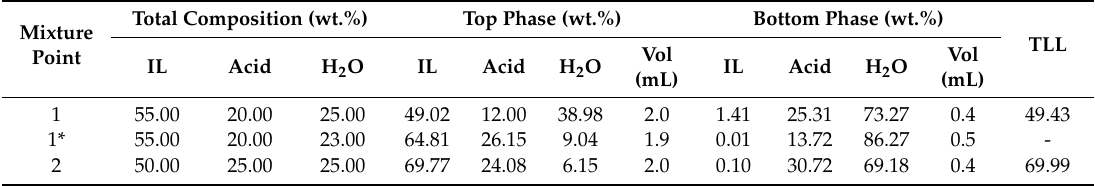
Table 1. Quantification of phase composition for the aqueous biphasic system composed of [P 44414 ]Cl and CH 3 COOH at 313 K (TLL—Tie Line Length). The mixture point 1* has the same initial [P 44414 ]Cl and CH 3 COOH concentration as mixture point 1 plus 2.00 wt.%